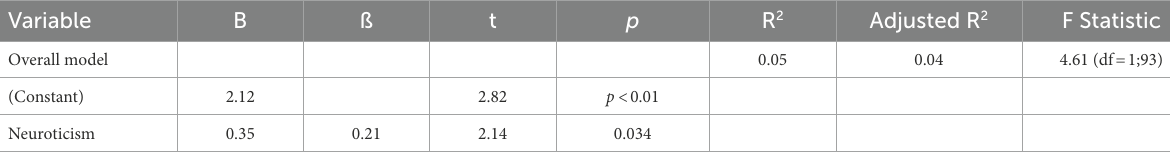
TABLE 5 Regression analysis summary for agreeableness predicting holacracy satisfaction.